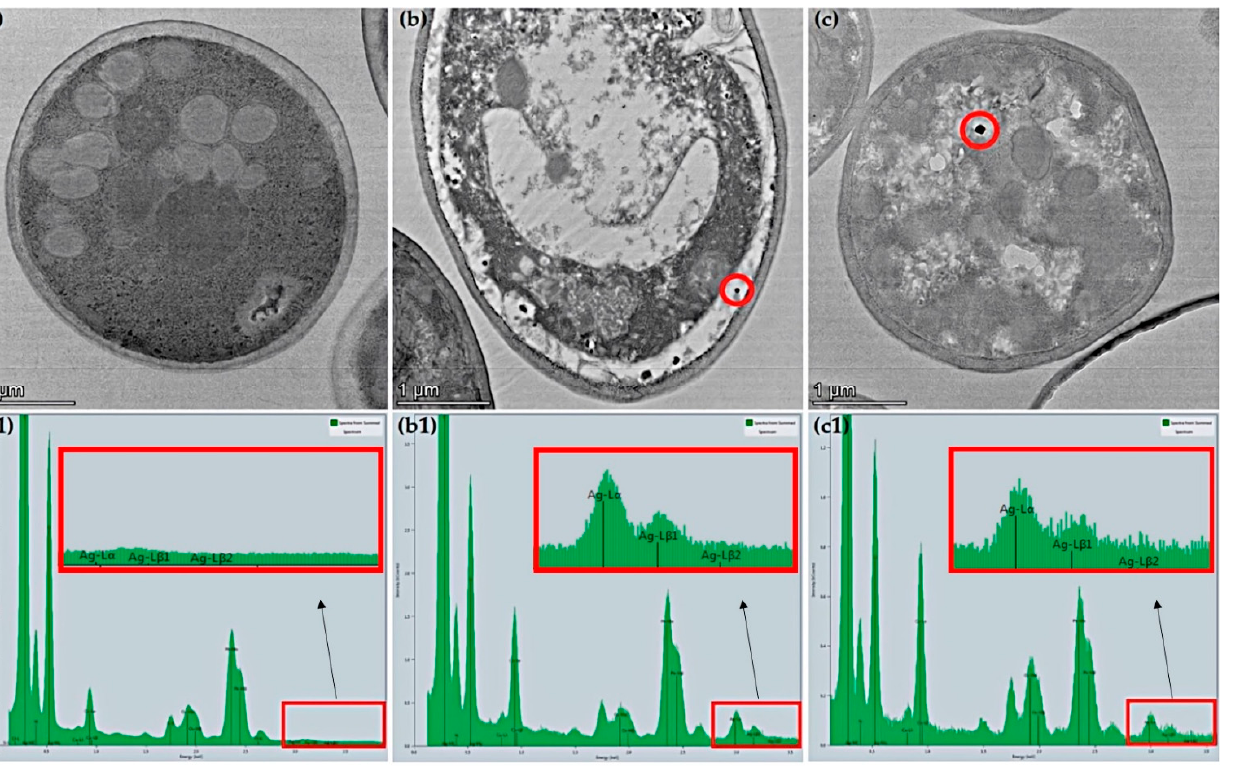
Figure 6. TEM micrographs of NS commercial yeast at 14,000× magnification. ( a ) depicts yeast exposed to 0 mg/L AgNO 3 . Both ( b , c ) depict yeast exposed to 22.5 mg/L AgNO 3 . The dark spots enclosed in a red circle in ( b , c ) are silver nanoparticles formed due to AgNO 3 exposure. ( a1 , b1 , c1 ) are the EDS spectrums that correspond to the image directly above them.